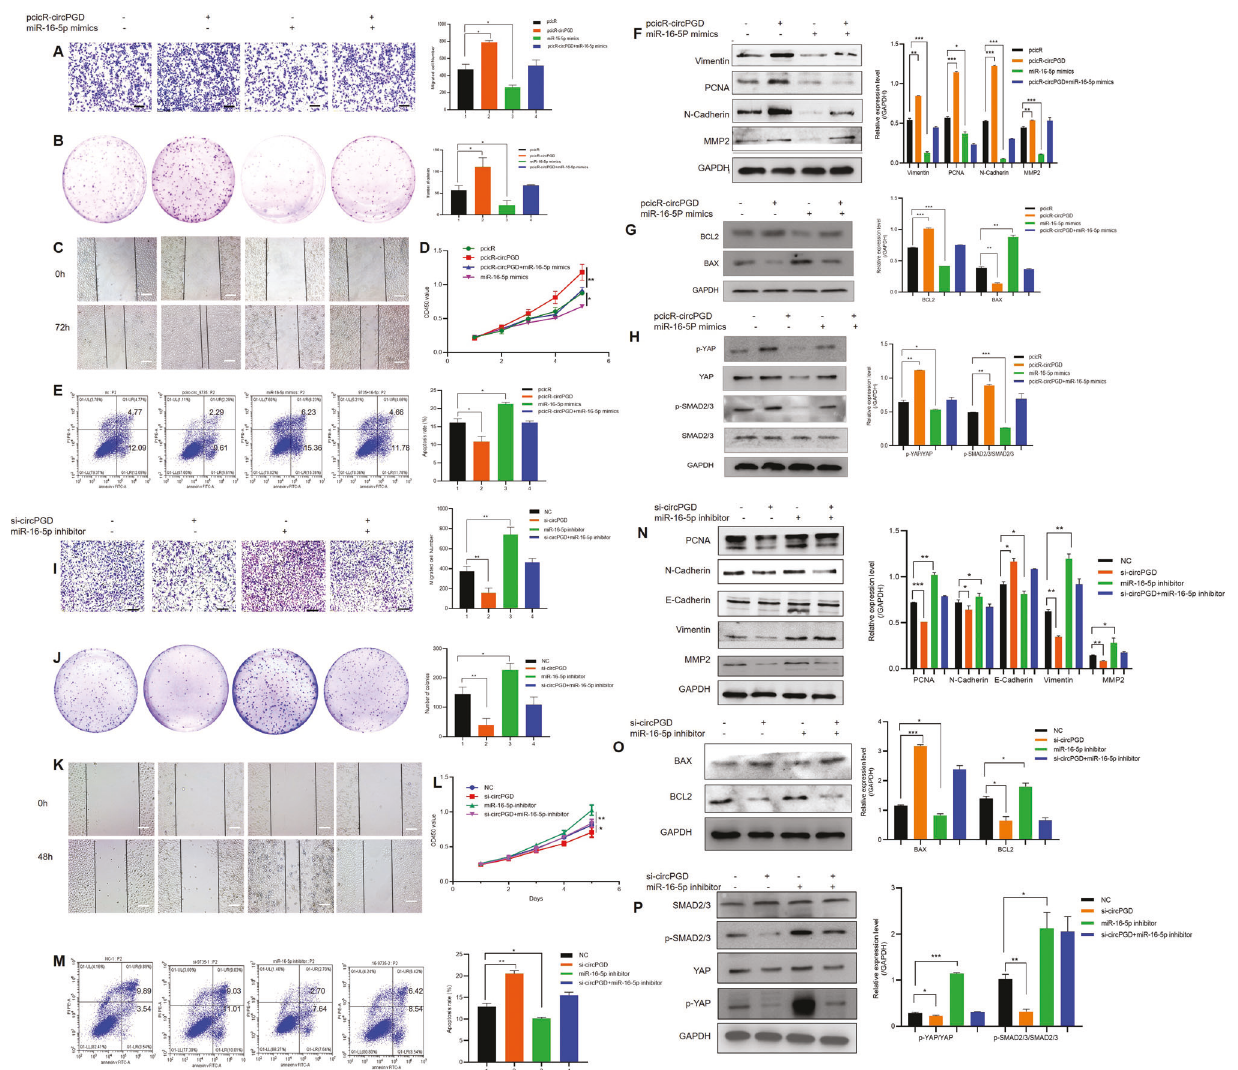
Fig. 4 MiR-16-5p reverses circPGD ability to promote GC progression. A Transwell migration assay (scale bars = 100 μ m), B colony- formation, C wound healing (scale bars = 50 μ m), D CCK-8, and E apoptosis assays analyzed the impact of circPGD plasmids and miR-16-5p mimics on BGC-823 cell growth, metastasis, and apoptosis. F Western blotting assay suggested the role of miR-16-5p mimics in decreasing Vimentin, PCNA, N-Cadherin, and MMP2 levels, which were increased by the transfection of circPGD plasmids. G MiR-16-5p mimics abolished circPGD effect on the BCL2 and BAX levels. H Impact of circPGD and miR-16-5p mimics on SMAD2/3, p-SMAD2/3, YAP, and p-YAP. I – M Roles of si-circPGD and miR-16-5p inhibitor in cell growth, migration as well as apoptosis. N , O , and P Western blotting examined the effects of si- circPGD and miR-16-5p inhibitor role in protein levels (western blot strips are cropped, original images can be provided on request). * p < 0.05, ** p < 0.01, *** p <